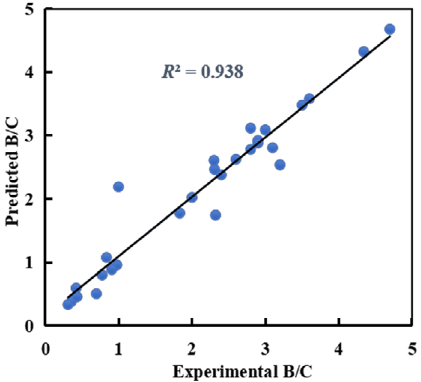
Fig. 6 Goodness of fit (input variables are T , Q , P , In_BCl 3 , In_CH 4 , and In_H 2 ).